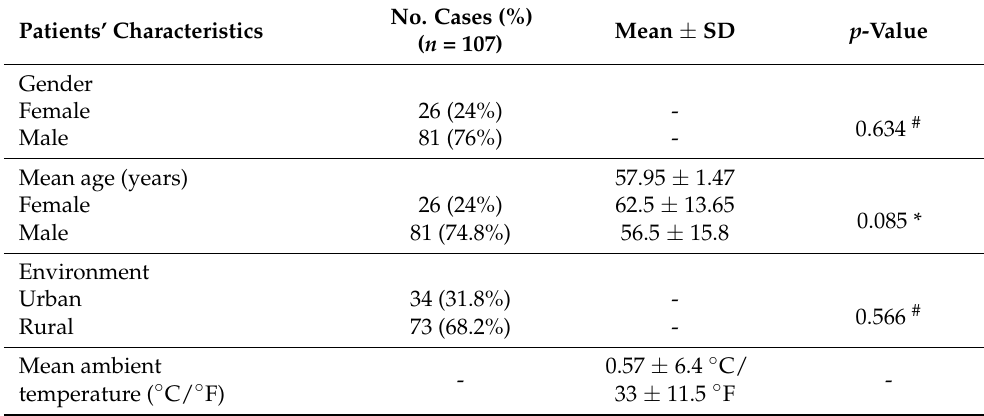
Table 2. General characteristics of the patients included in our study. Patients’